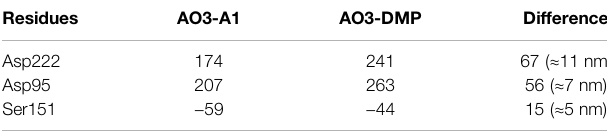
TABLE 2 | Calculated (calc.) and experimentally measured (expl.) absorption wavelengths for AO3-A1 and AO3-DMP (nm). Groups